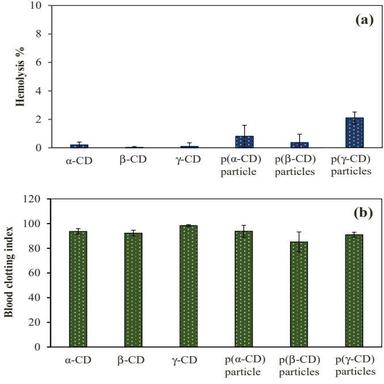
(a) Hemolysis and (b) blood clotting index values of 1 mg/mL concentration of α-CD, β-CD, γ-CD, and p(α-CD) particles, p(β-CD) particles, and p (γ-CD) particles.